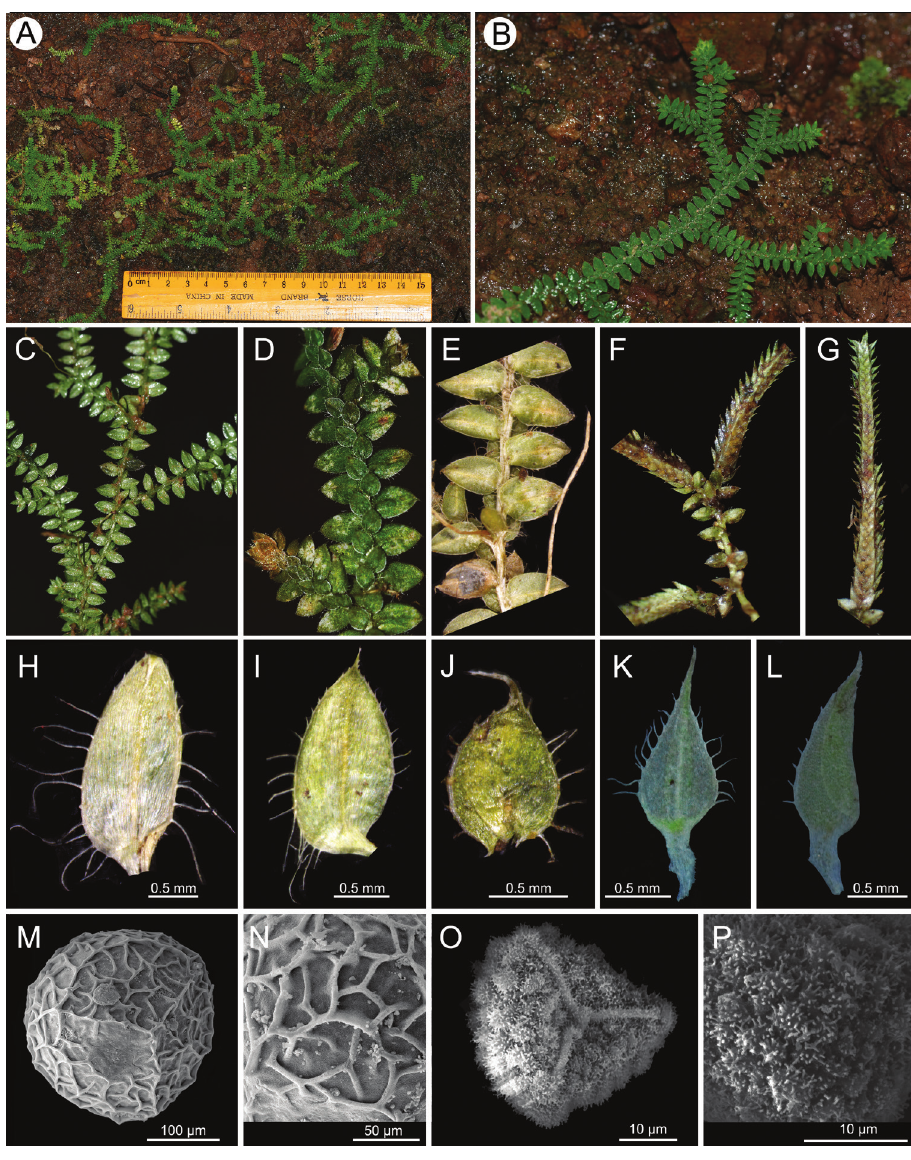
Figure 2. Selaginella wuyishanensis A, B habit C abaxial view of portion of branch D portion of branch showing the dorsal leaves E portion of branch showing the ventral and axillary leaves F, G strobili H axil- lary leave I axillary leave J dorsal leave K ventral sporophyll L dorsal sporophyll M proximal surface of megaspores N detail of megaspore surface O microscopic structures of microspore surface P proximal surface of